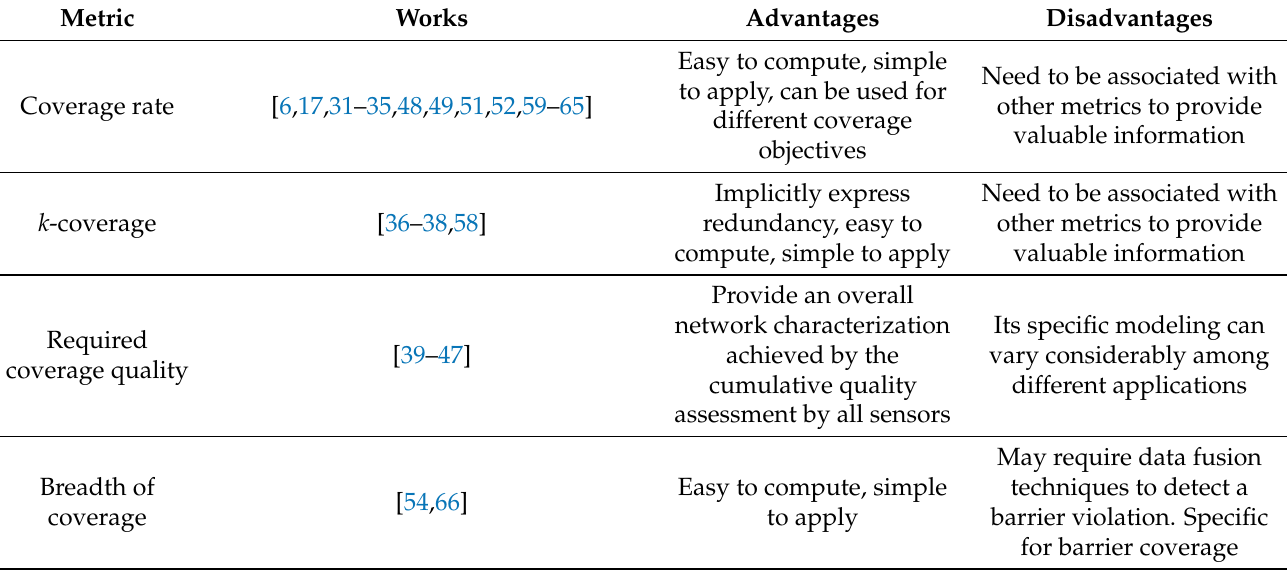
Table 4. Comparative analysis of spatial quality